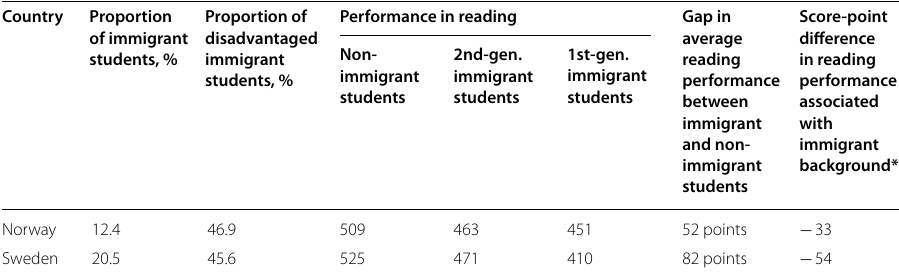
Derived from: OECD, PISA 2018 Database, Tables II.B1.9.1 and II.B1.9.3; https:// doi. org/ 10. 1787/ 88893 40370 51). OECD average: 24 − *After accounting for gender, and students’ and schools’ socioeconomic status